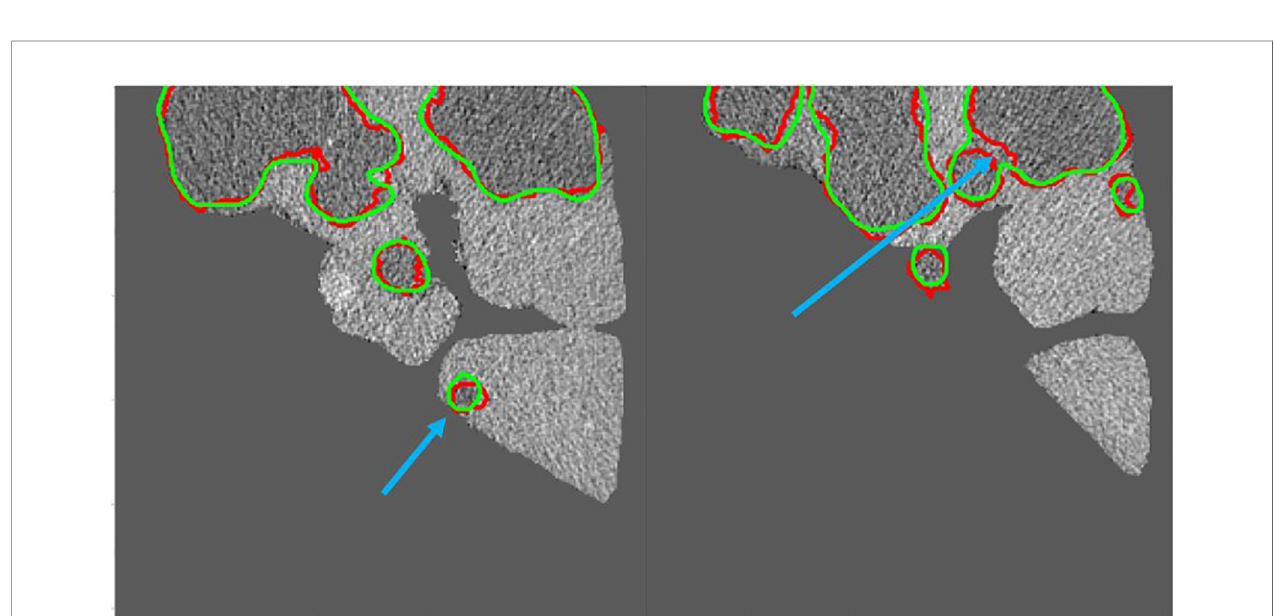
FIGURE 10 | Green contour shows the predicted results by S-Net models, while red shows the gold standard. The small and multiple lesions, marked by the blue